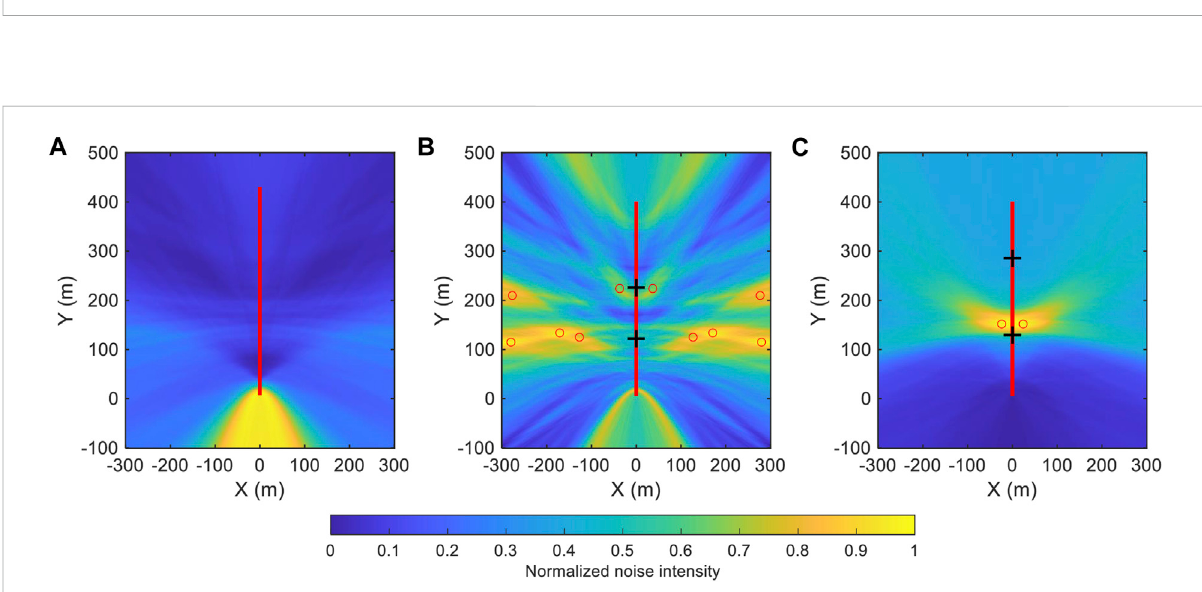
FIGURE 3 The ambient noise intensity around the fi ber-optic cable. (A – C) are the noise intensity of segment 1, 2, and 3, respectively in Figure 1. The red lines indicate the fi ber-optic cable. The black crosses in (B,C) are the road intersections, while the red circles are the local maxima of noise intensity.